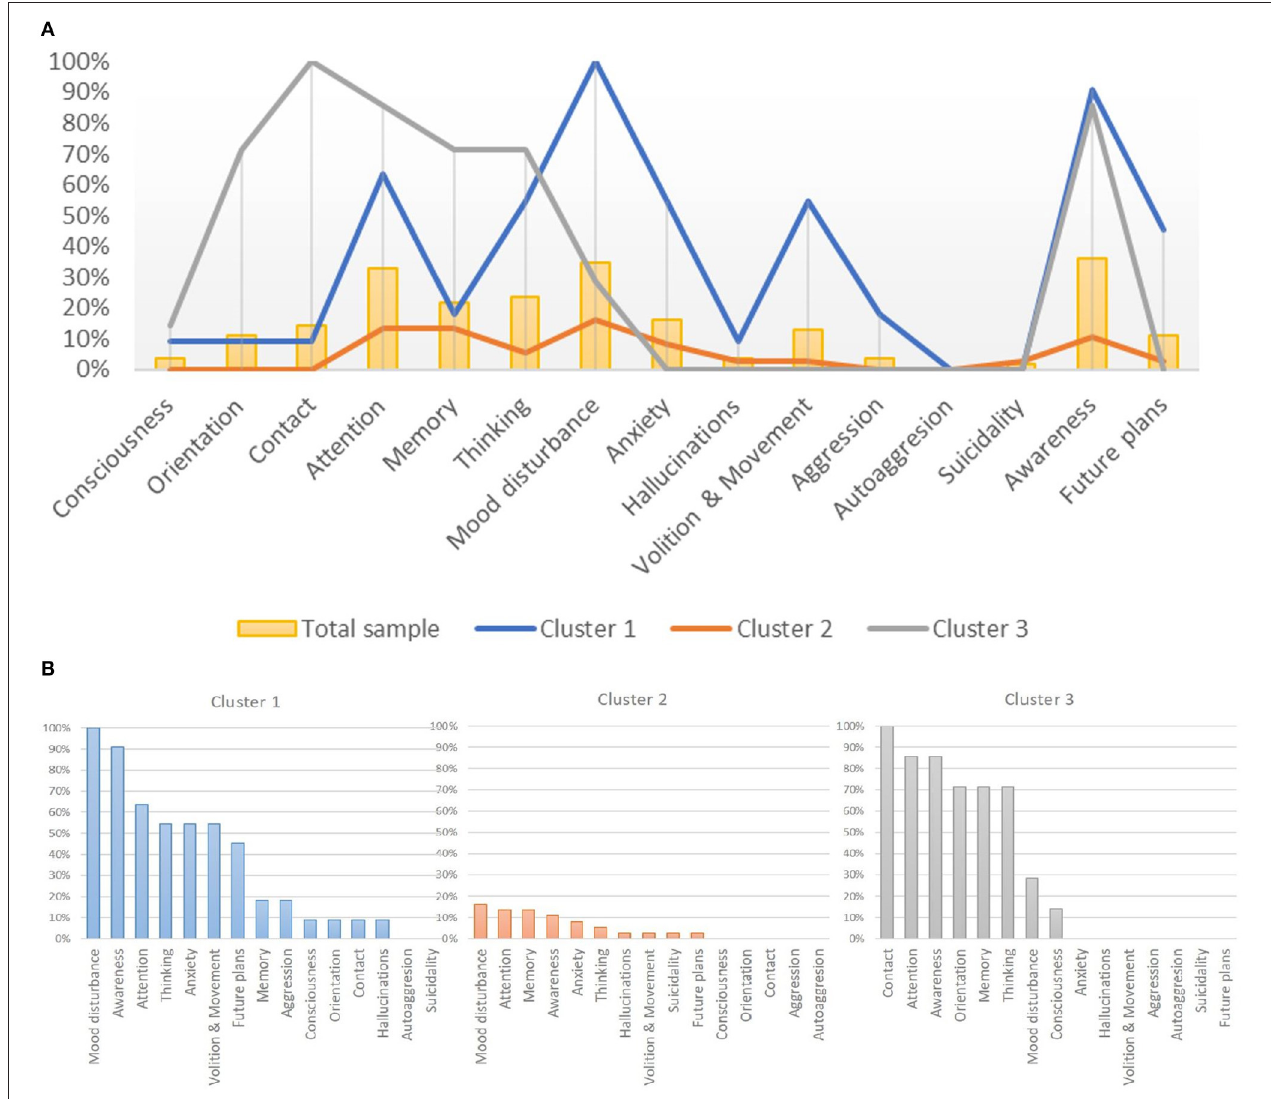
FIGURE 2 | (A) The frequency of psychopathological syndromes in patients with COVID-19 infection within three defined clusters. (B) Psychopathological profiles of inpatients with COVID-19 infection in each determined cluster. and instrumental methods: a higher percentage of lung damage [31% (35) vs. 15% (18), p < 0.001]; higher level of C-reactive protein [126 mg/L (236) vs. 10 mg/L (21), p < 0.001]; lower saturation [89% (13) vs. 97% (4), p < 0.001]; and higher respiratory rate [21 (6) vs. 18 (4), p < 0.001].